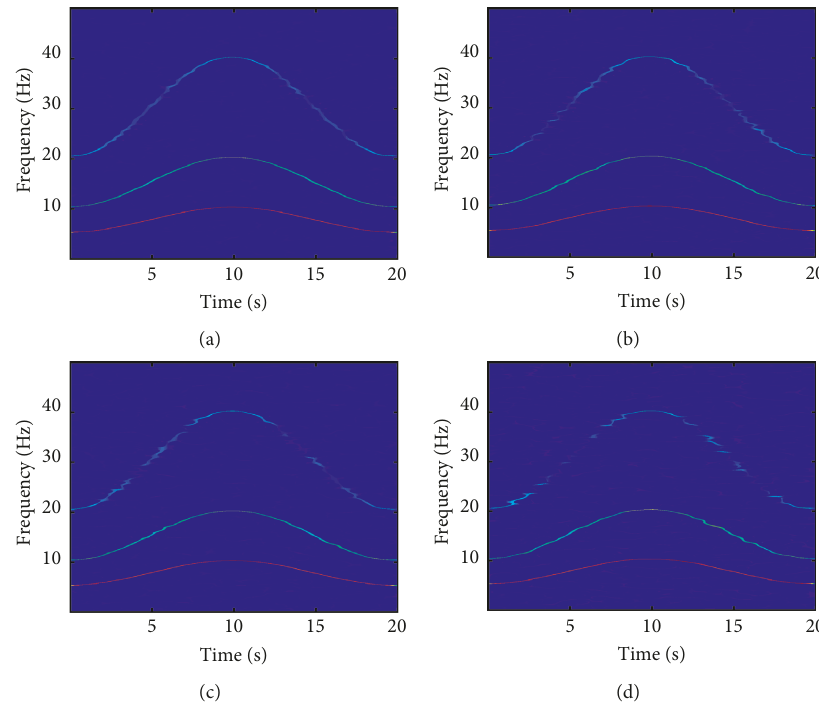
Figure 14: VMD-SET time-frequency representation of SFM signal under different SNR: (a) 10dB, (b) 0dB, (c) − 10dB, and (d) − 20dB.